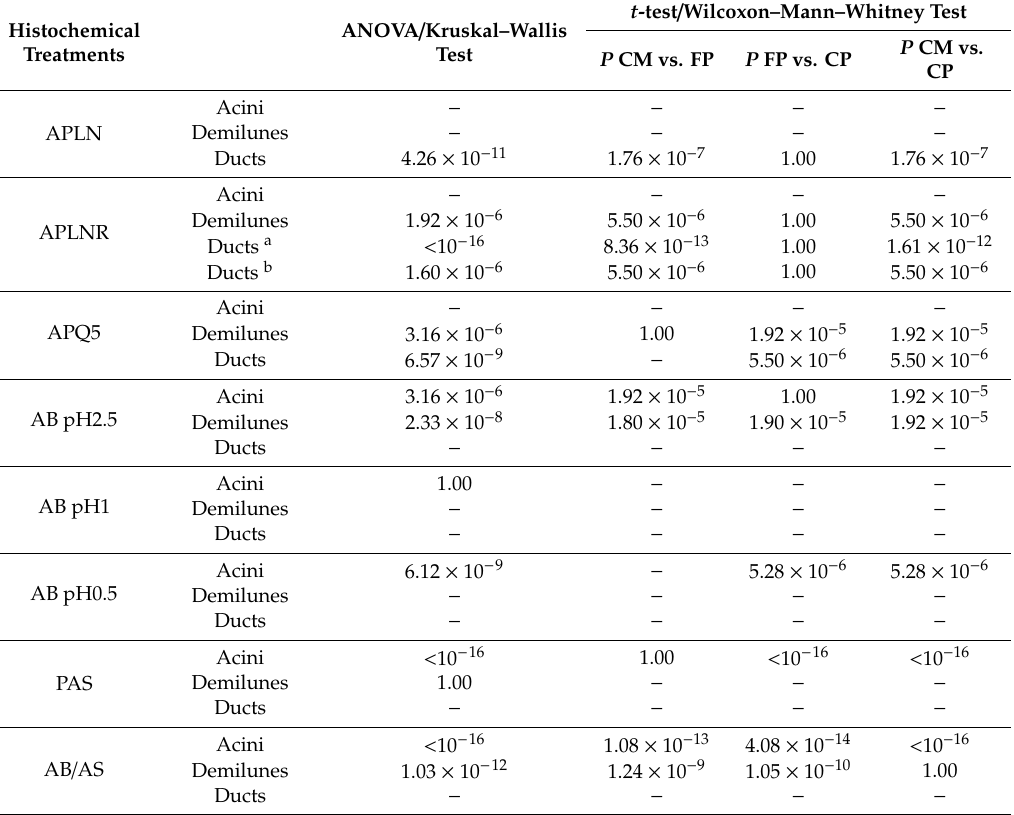
Table 3. Statistical significance of di ff erences ( p ≤ 0.01) for each histochemical treatment among di ff erent experimental treatments, as performed by one-way ANOVA and Kruskal–Wallis tests and respective pairwise comparisons, as performed by independent samples t -test and Wilcoxon–Mann–Whitney tests. P- values were adjusted for multiple testing using the Holm correction.